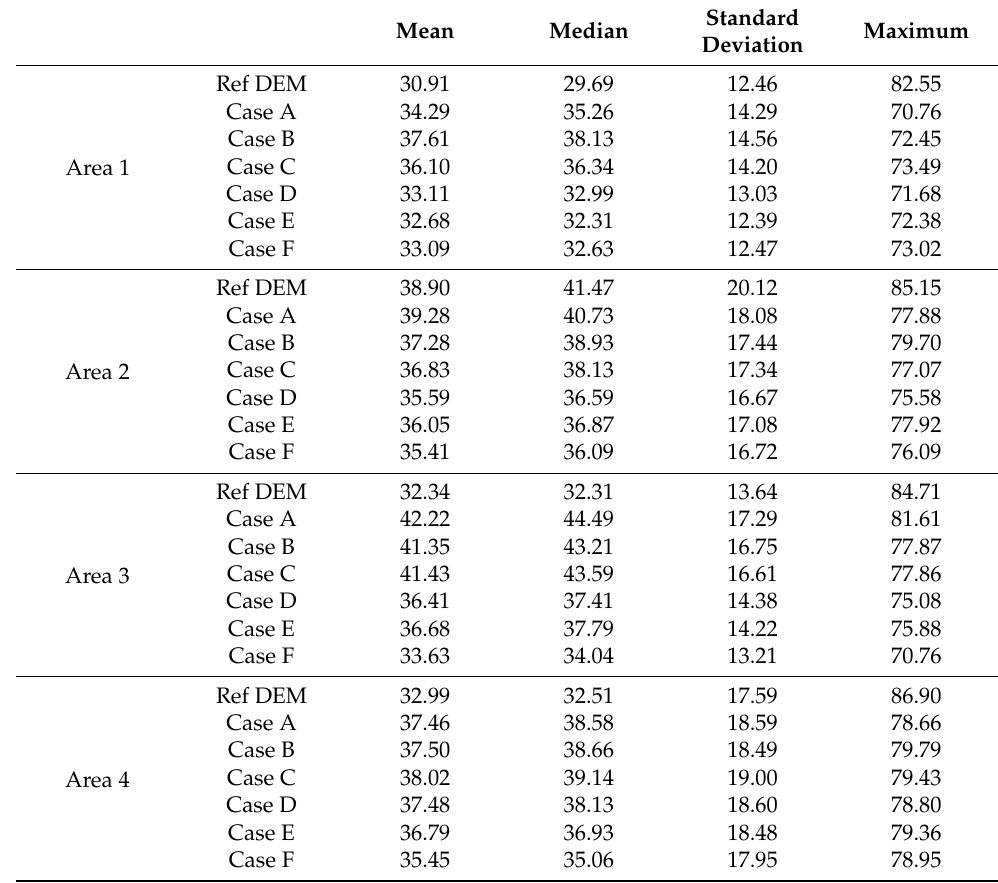
Table 3. The statistics of surface slope. Ref DEM represents the reference